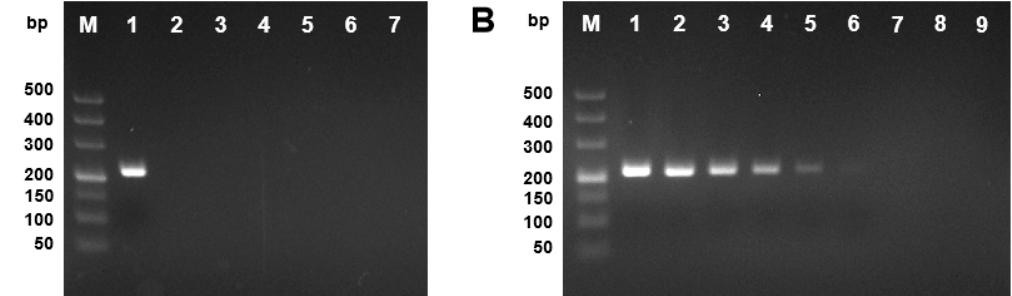
Figure 7. Specificity and sensitivity of the developed PCR based on TUB sequence for detection of D. citri . ( A ) PCR product 217 bp of D. citri (NFHF-8-4) was shown with 2% gel electrophoresis (lane 1). Lanes 2–6 are representatives of D. citriasiana (XFAL-1-1), D. discoidispora (NKDL-1-2), D. eres (NFIF-1-1), D. sojae (NFGL-1-5), and D. unshiuensis (NFIF-1-6), respectively, Lane 7 is the double sterile water (ddH 2 O) as negative control, and lane M, 50 bp ladder. ( B ) Sensitivity was investigated with a gDNA serial dilution. Lane 1–8 are gDNA of 10 2 , 10 1 , 10 0 , 10 − 1 , 10 − 2 , 10 − 3 , 10 − 4 , and 0 ng in 20 μ L reaction mixture, respectively. Lane 9 is the ddH 2 O as negative control and lane M, 50 bp ladder.